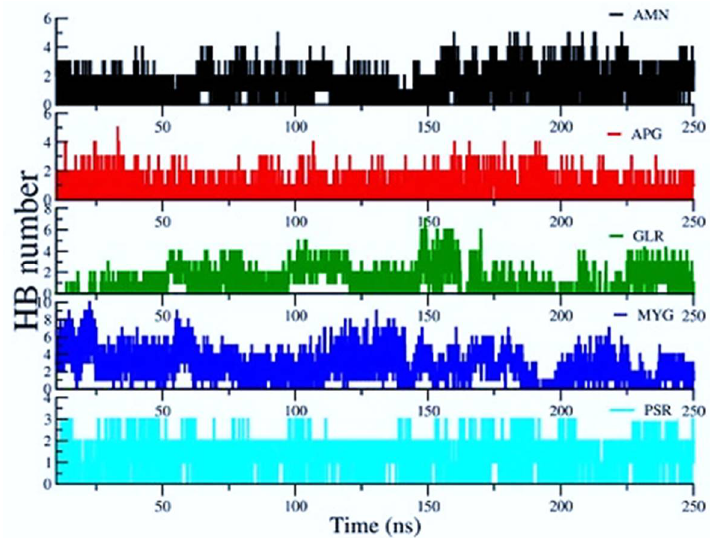
Figure 8. Hydrogen bonds (HBs) between ligands and protein residues.